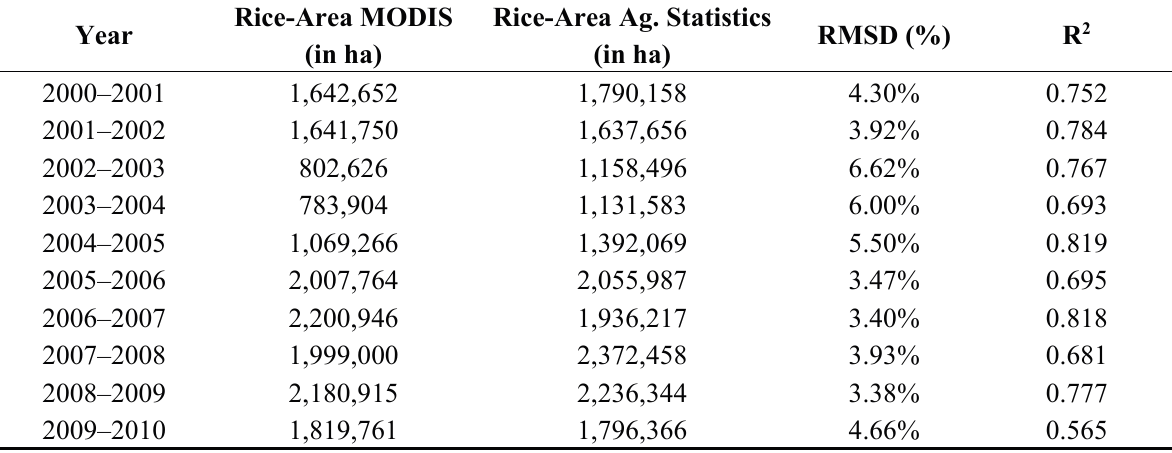
Table 5. Correlation between districts wise MODIS derived rice cropped areas and agriculture statistics for the selected 10 spatial